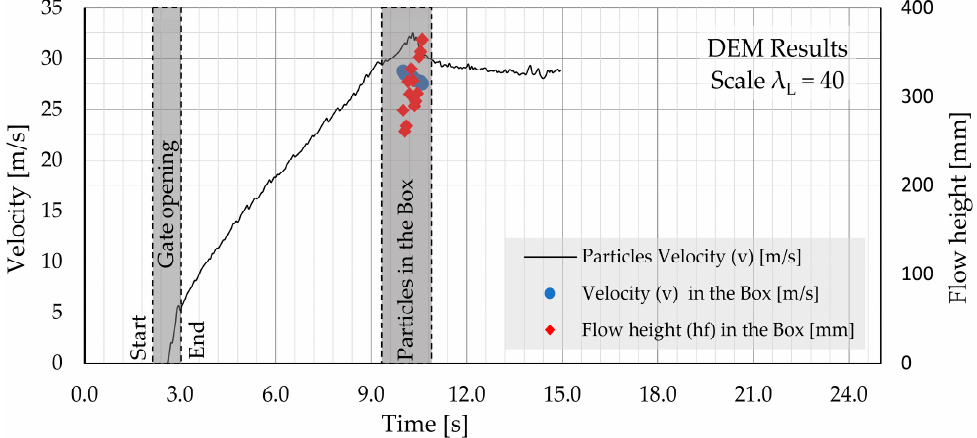
Figure 14. Results of the scaled DEM model for velocity ( v ) and flow height ( hf ).